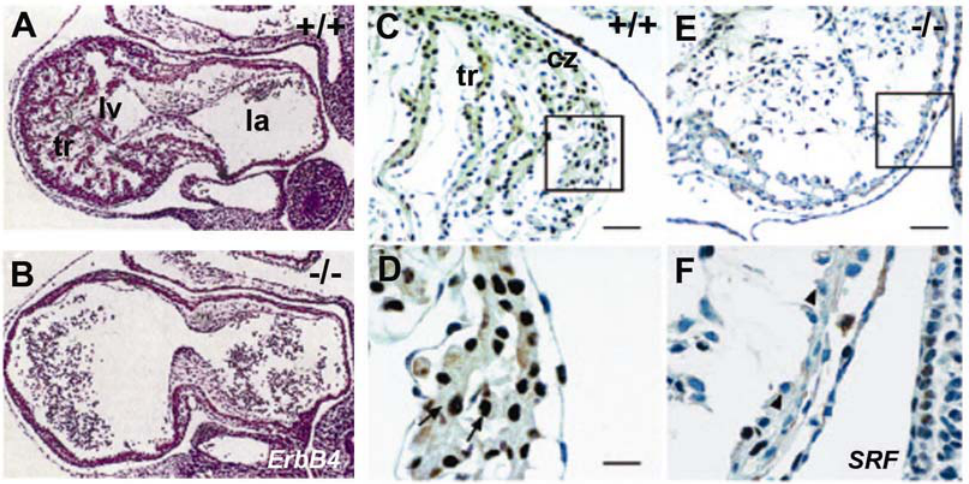
FIGURE 5. Development of the trabeculated myocardium. (A,B) Sagittal sections through wildtype, +/+ (A) and ErbB4 -/- (B) E10.5 embryonic hearts. The neuregulin-ErbB2/B4 signaling pathway is crucial for normal trabeculation of the ventricles; embryos lacking either component fail to develop trabeculations as illustrated by the ErbB4 -/- mutant (B). (C–F) Immunostaining for SRF on frontal sections through wild type, +/+ (C,D) and mutant, -/- (D,F) hearts at E10.5. D and F represent magnified images of the boxes in C and E, respectively (scale bars = 10 μ m), SRF is required to maintain appropriate contractile cytoarchitecture in the developing myocardium, which in turn is essential for the development of the trabeculations. la, left atrium; lv, left ventricle; cz, compact zone; tr, trabeculations. A and B are reproduced from Gassmann et al.[53], ©1995 with permission from Nature Publishing Group; C–F are reproduced from Miano et al.[62], with permission from The National Academy of Sciences